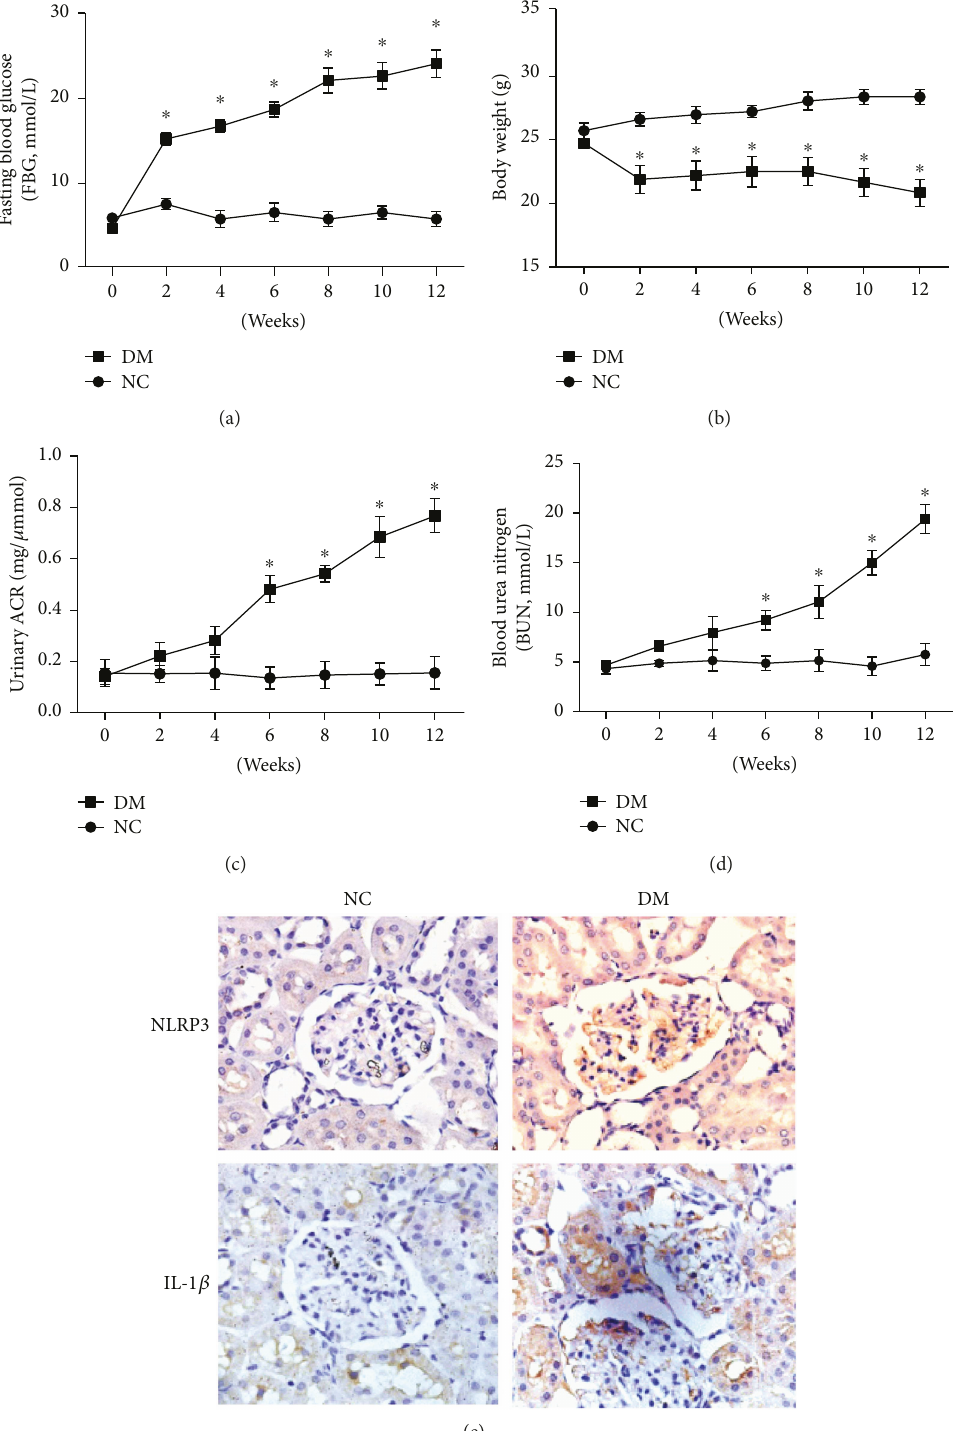
Figure 1: STZ-induced changes in FBG, body weight, ACR, and renal function of diabetic mouse. Male C57BL/6 mice were divided into diabetes mellitus group (DM group, n = 10 ) and normal control group (NC group, n = 10 ). Every two weeks, fasting blood glucose (a), body weight (b), ACR (c), and BUN (d) levels were examined. (e) STZ-induced expression of NLRP3 and IL-1 β in renal tissue was observed by immunohistochemistryandlightmicroscopy(200 × ).Dataarepresentedasmeans ± SD. ∗ p < 0 05